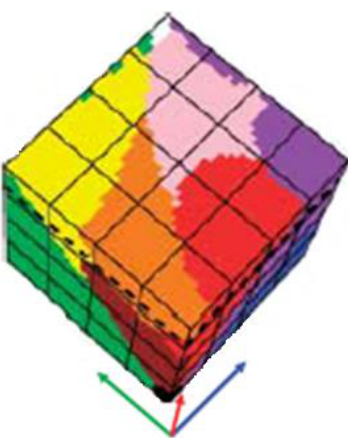
Figure 19. Adapted from [172]. Unlike a MS reflectance space hyperpolyhedralization difficult to think of and impossible to visualize when the number of channels is superior to three, an RGB data cube polyhedralization is intuitive to think of and straightforward to display. For example, based on psychophysical evidence, human basic color (BC) names can be mapped onto a monitor-typical RGB data cube. Central to this consideration is Berlin and Kay’s landmark study of a “universal” inventory of eleven BC words in twenty human languages: black, white, gray, red, orange, yellow, green, blue, purple, pink and brown [171].